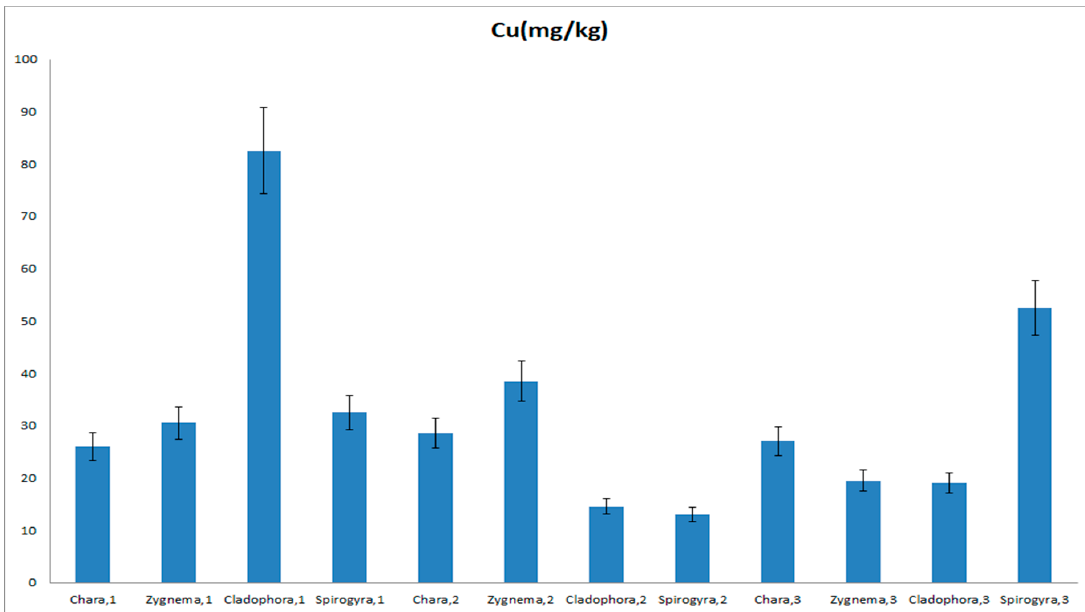
Figure 3. Cu contents of the four algae studied (for the three sites considered).